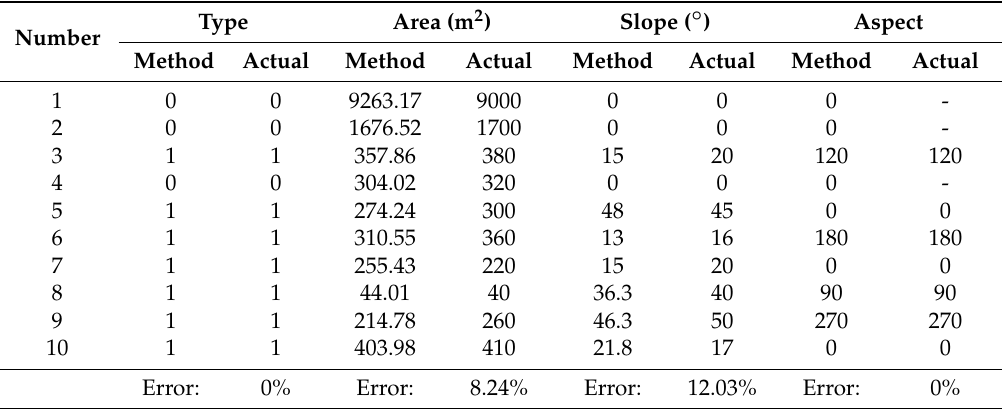
Table 1. Accuracy analysis for 10 selected rooftop